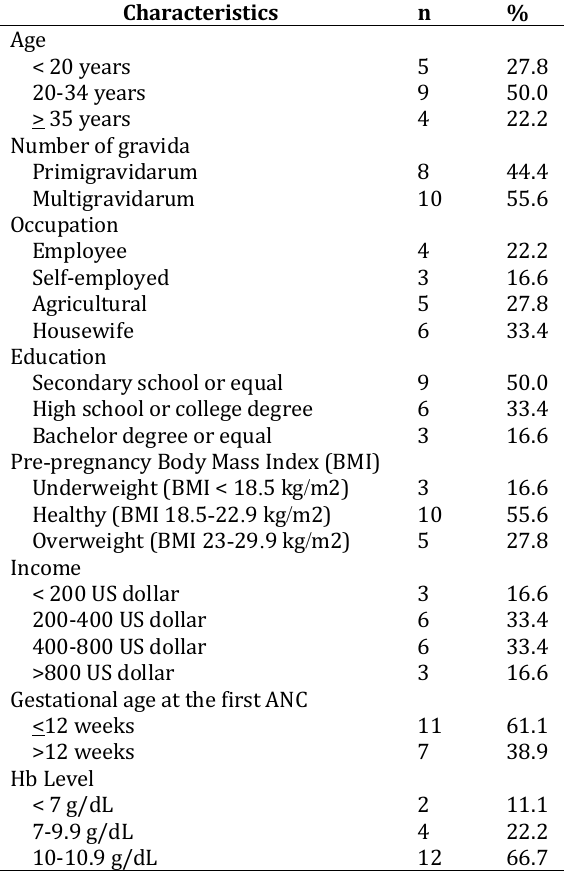
Table 2. Demographic characteristics of pregnant women in the in-depth interviews